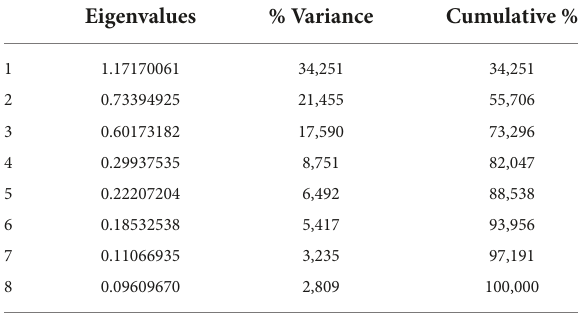
the RN coastal, Ibiapaba, and Maciço, there was an overlap of morphological variation of the other pairs between